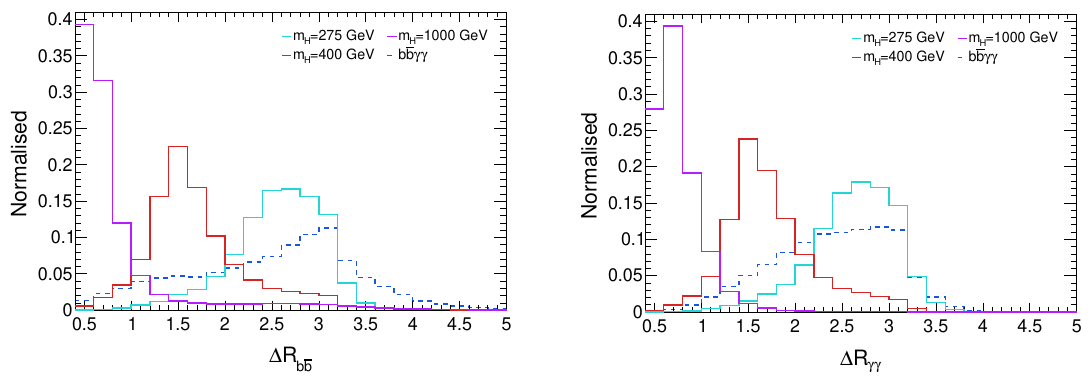
Figure 3 . Normalised distributions of (cid:1) R bb and (cid:1) R (cid:13)(cid:13) for heavy Higgs masses, m H = 275, 400 and 1000 GeV with dominant b (cid:22) b(cid:13)(cid:13)